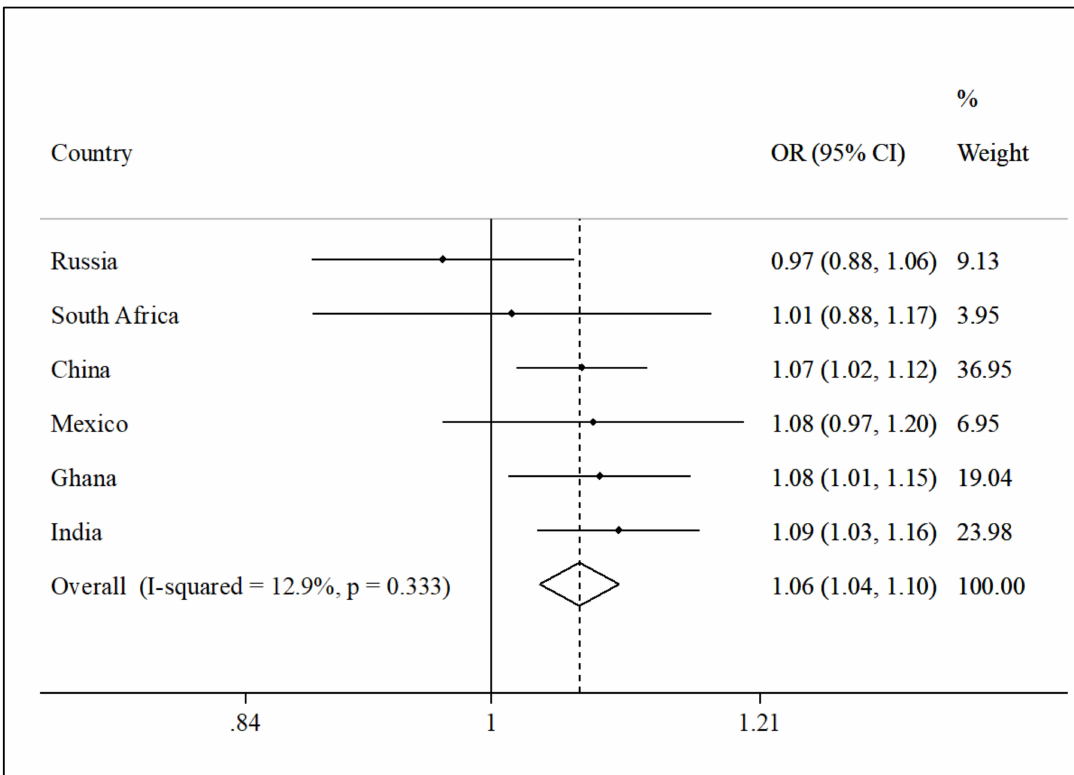
Figure 2. Country-wise association between sedentary behavior (per one hour increase / day) and sarcopenia, estimated by multivariable logistic regression. Abbreviations: OR, odds ratio; CI, confidence interval. Models are adjusted for age, sex, education, wealth, physical activity, smoking, alcohol consumption, chronic conditions, and body mass index. Overall estimate was obtained by meta-analysis with fixed e ff